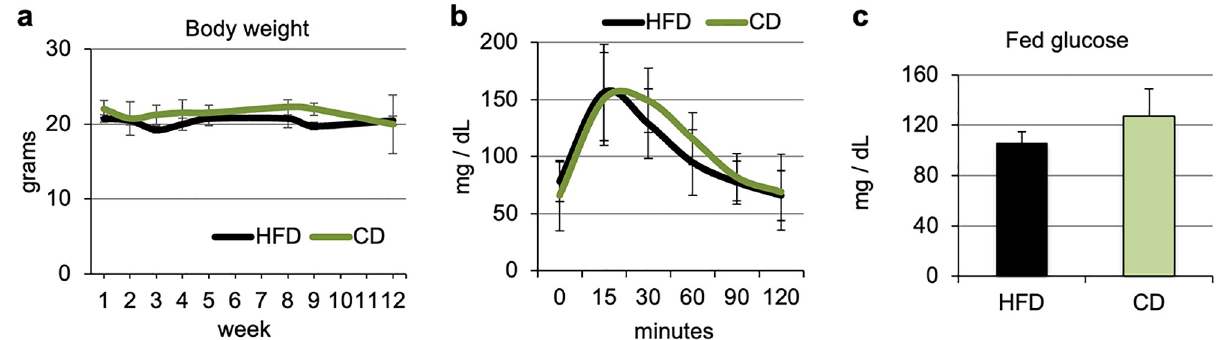
Fig 3. cDNA-uPA/SCID mice do not develop insulin resistance upon HFD feeding. cDNA-uPA/SCID mice were fed a HFD or CD for 12 weeks. (a) Body weight (n = 4); (b) GTT on week 12. Mice were fasted for 7 hours and a bolus of glucose (1 mg/g body weight) was given intraperitoneally. Blood glucose was measured at the indicated times (n = 4); (c) Fed blood glucose was measured 2 days after the GTT (n = 4).